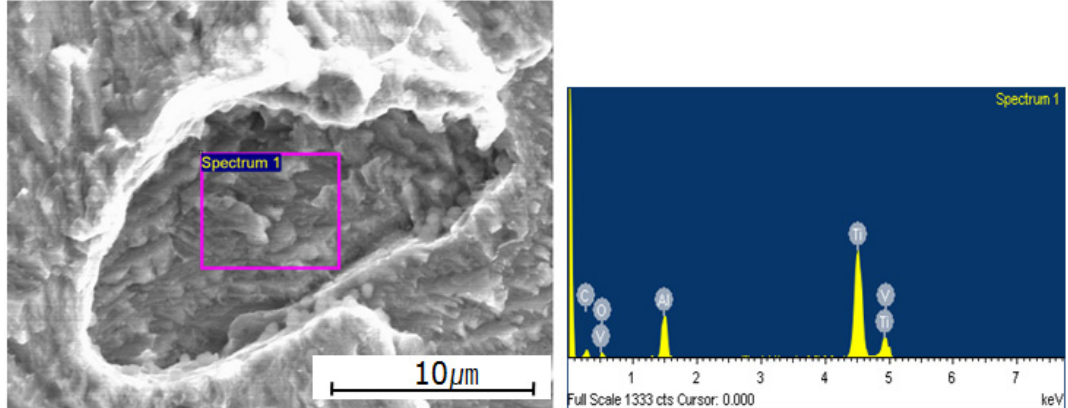
Figure 12. SEM image of fracture surface.